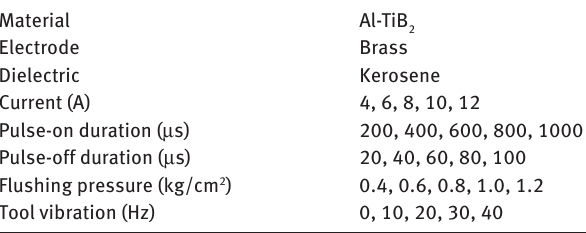
Table 1 EDM parameters.